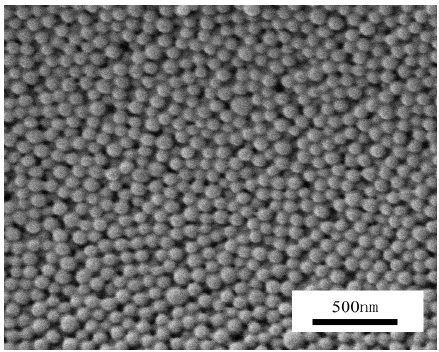
Figure 6. Scanning electron microscopy (SEM) image for the lyophilized triblock copolymer P(DMA 33 - b -NIPAM 32 - b -TFEMA 500 )-S-(C=S)-S-C 12 H 25 . Polymerization conditions: P(DMA 33 - b -NIPAM 32 )-S-(C=S)-S- C 12 H 25 :[APS] = 3:1, P(DMA 33 - b -NIPAM 32 )-S-(C=S)-S-C 12 H 25 :[TFEMA] = 1:500, [EGDMA]:[TFEMA] = 5:100, 70 °C, 120 min.